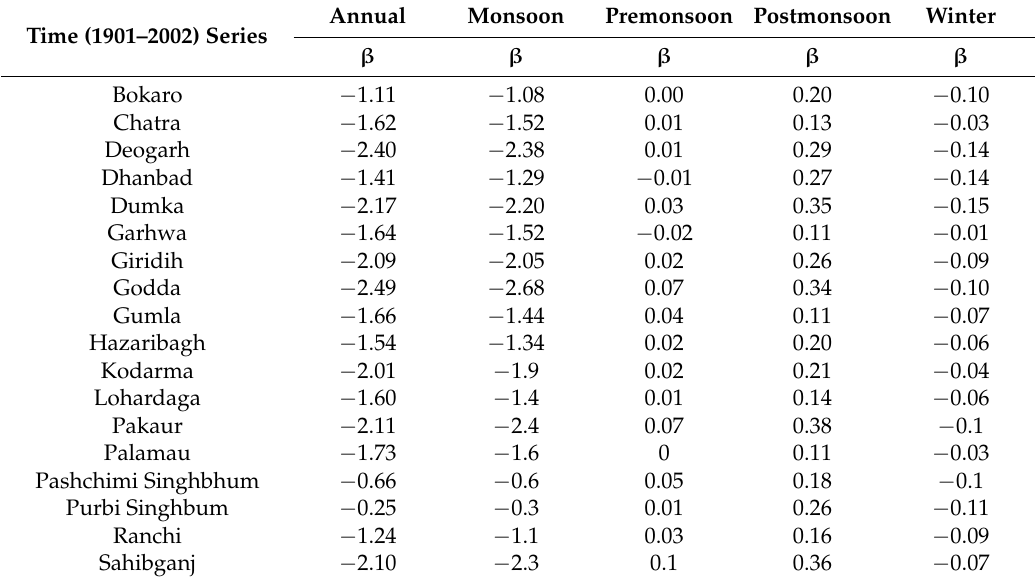
Table 2. Sen’s slope ( β ) value of Annual and Seasonal rainfall (1901–2002).